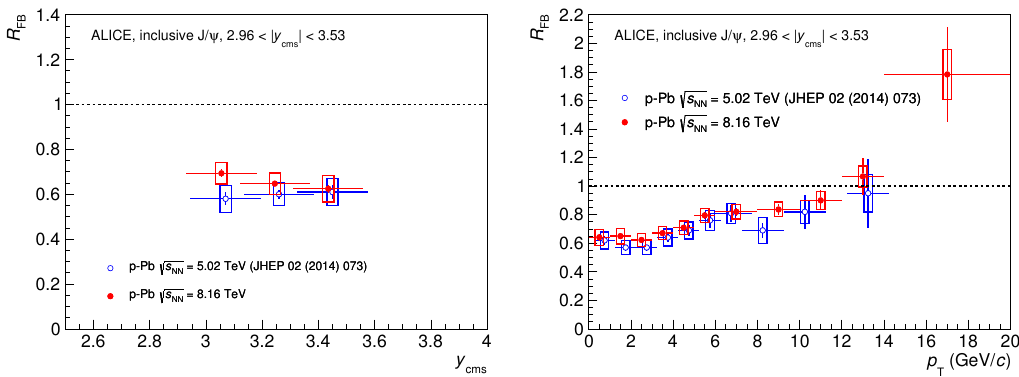
Figure 8 . The ratio R FB between the inclusive J/ nuclear modi(cid:12)cation factors, as a function of y cms (left) and p T (right), relative to 2 : 96 < j y cms j < 3 : 53. The horizontal bars correspond to the bin size. The vertical error bars represent the statistical uncertainties, the boxes around the points the systematic uncertainties. The results are compared with those obtained at The latter have been plotted at a slightly shifted y cms and p T , for better